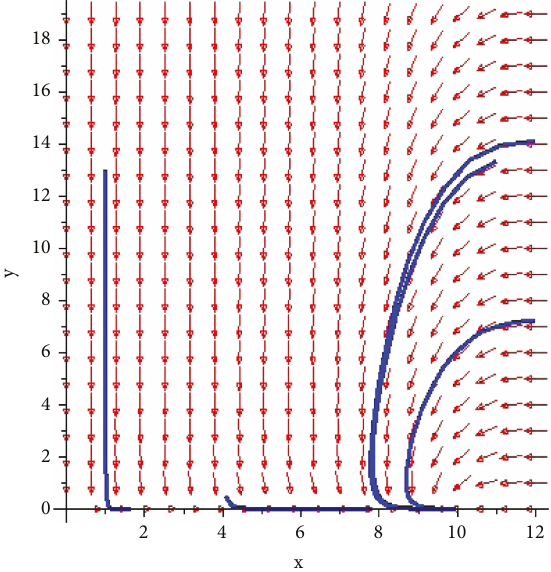
Figure 3: The vector diagram of system (8) where r = 4 , a = 0 4 , b = 0 5 , m 1 = 12 , and m 2 = 14